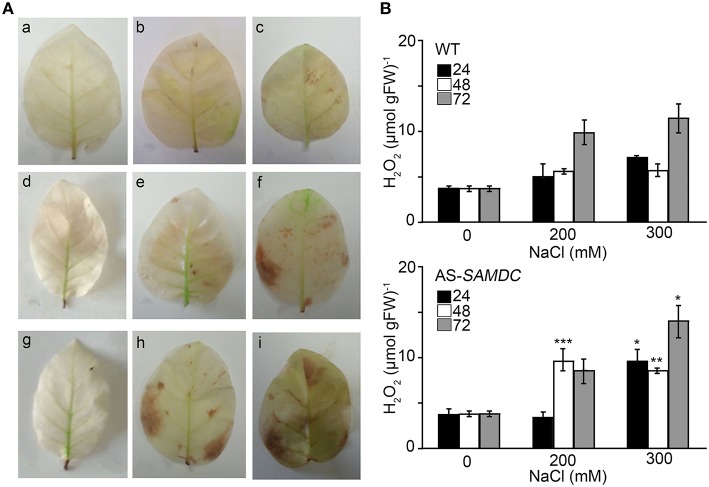
Levels of Hydrogen peroxide in WT and AS-SAMDC leaves under control and NaCl treatment. (A)
In situ detection of H2O2 leaves of WT and AS-SAMDC plants after exposure to 200 and 300 mM NaCl; 24 h (a–c), 48 h (d–f), and 72 h (g–i), control (a,d,g); 200 mM NaCl (b,e,h); 300 mM NaCl (c,f,i). Images are from a single representative experiment replicated three times. (B) Hydrogen peroxide levels in WT and AS-SAMDC control plants. Data are means ± SD of three biological replicates. Asterisks indicate significant difference of mean values of AS-SAMDC from WT (Student's t-test; *P < 0.05, **P < 0.01, and ***P < 0.001).